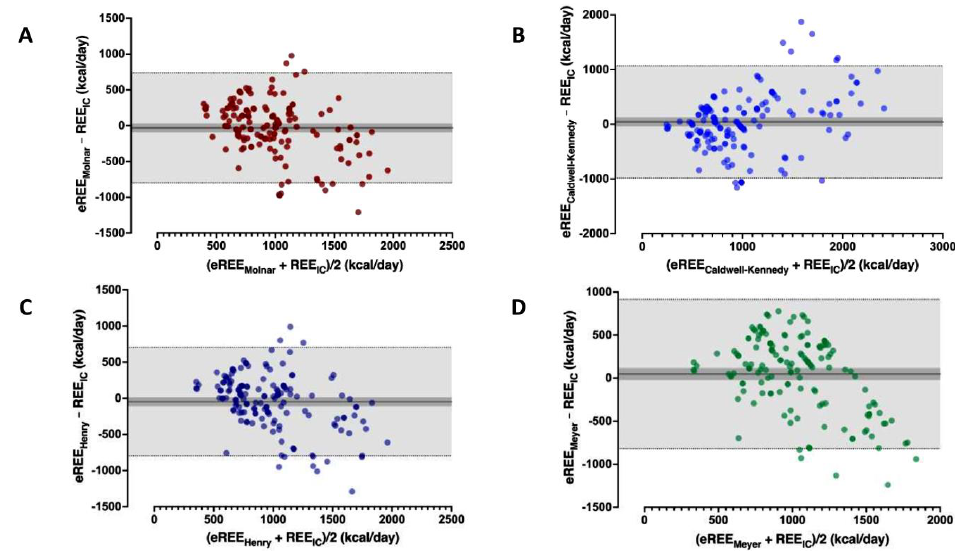
Figure 1. Bland–Altman plot whereby estimated by predicted equations’ resting energy expenditure (eREE) is compared to REE measured by IC (REE IC ) at ICU Day-3 or 4. ( A ). Molnar eREE compared to REE IC . ( B ). Caldwell–Kennedy eREE compared to REE IC . ( C ). Henry (Oxford) eREE compared to REE IC . ( D ). Meyer equation-C eREE compared to REE IC . The solid line indicates the percentage of agreement bias (%) and the light shade with the fine dotted lines indicates the limits of agreement (bias ± (1.96 × SD) = precision). Dark shade represents the 95% confidence intervals of the mean (bias).